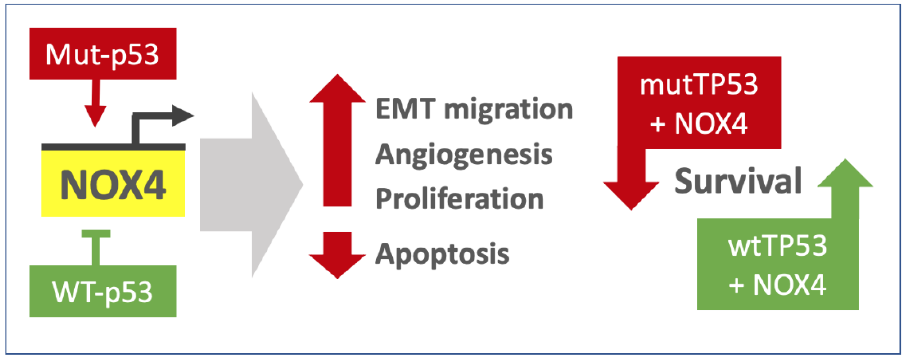
Figure 9. Schematic summary. Divergent effects of mutant versus WT p53 on NOX4 expression and downstream consequences on cancer progression programs ( left ). Contrasting effects of high NOX4 expression on survival outcomes in patients with WT versus mutant TP53 tumors ( right ).